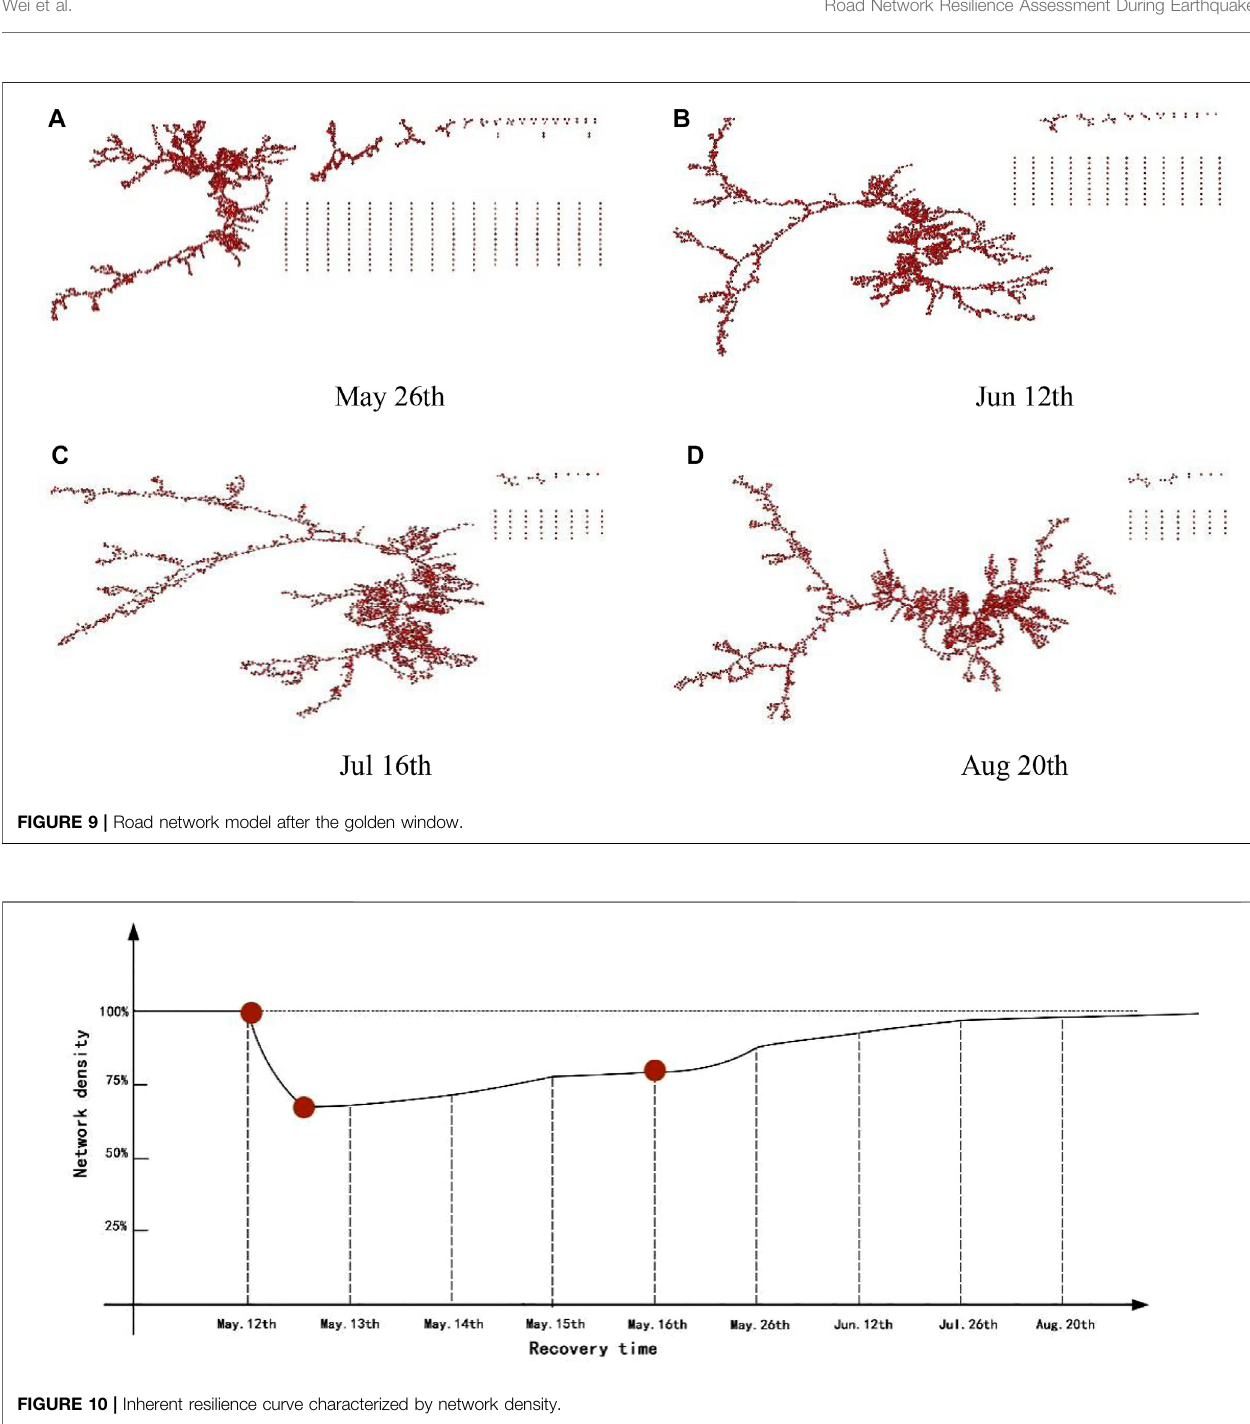
FIGURE 10 | Inherent resilience curve characterized by network